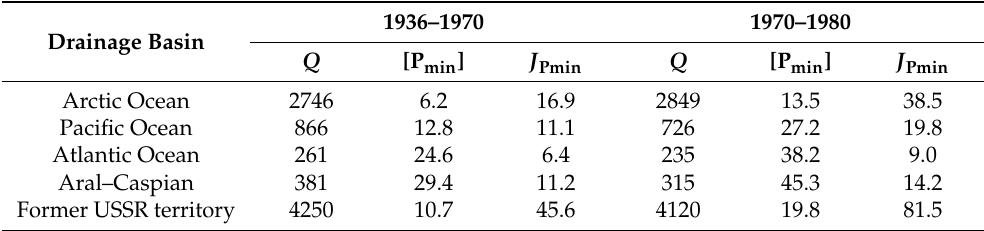
Table 12. Change in water runoff ( Q , km 3 /yr), concentration ([P min ], µ g/L) and runoff ( J Pmin , thous. t/yr) of dissolved mineral phosphorus in the USSR in 1936–1980 [54].